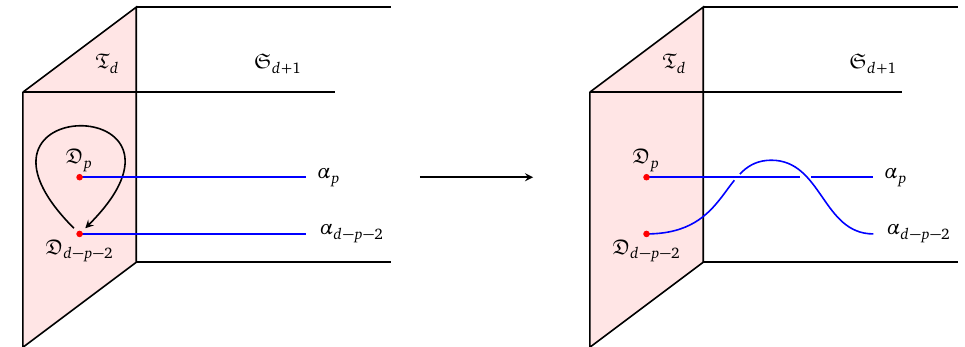
Figure 1: Moving a defect D of the relative theory T d − p − 2 of the relative theory T creates a braiding between the topological defects α d ∈ L and α of the TQFT S . d − p − 2 d − p − 1 d + 1